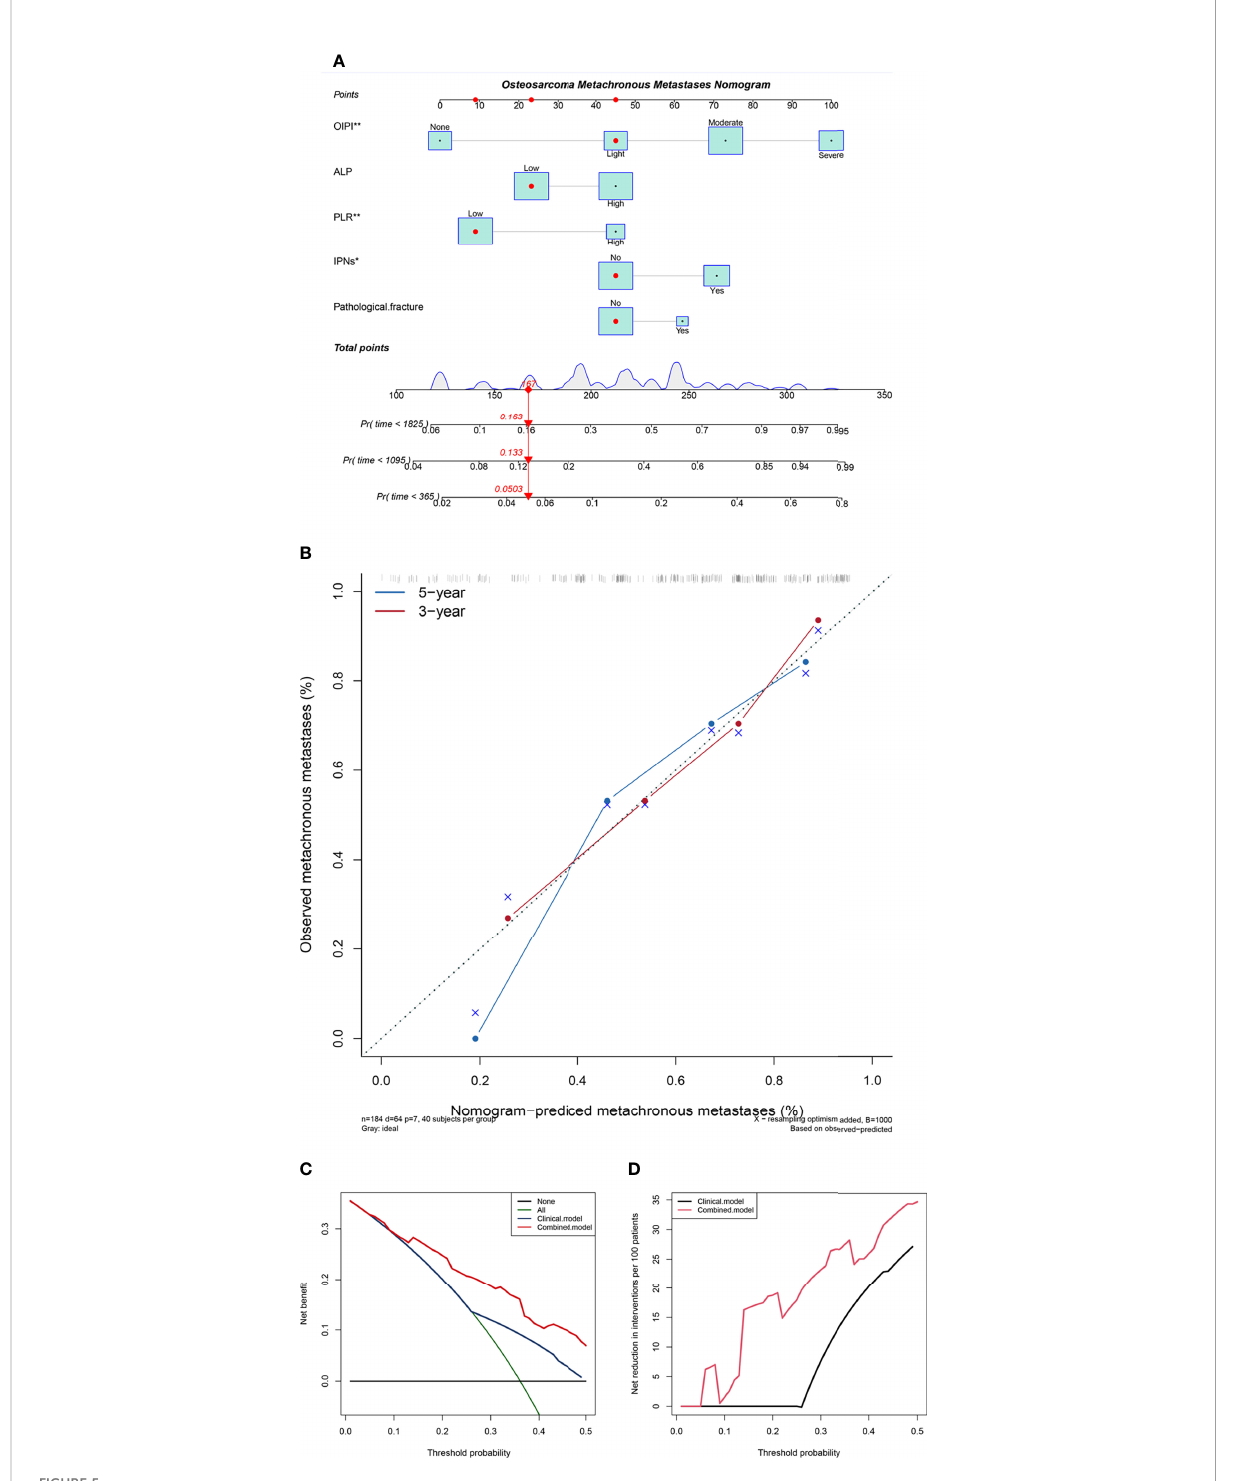
FIGURE 5 Construction and validation of the osteosarcoma metachronous metastasis nomogram. (A) The nomogram was constructed by combining OIPI, ALP, PLR, IPNs, and pathological fracture, and the sum of the scores for each covariate was the nomogram total score. (B) Calibration curves for the nomogram predicting 3- and 5-year metachronous metastasis of osteosarcoma patients. (C) The clinical net bene fi t curve of this nomogram. (D) Clinical net reduction curve for the nomogram. OIPI, osteosarcoma immune prognostic index; ALP, alkaline phosphatase; PLR, platelet – lymphocyte ratio; IPNs, indeterminate pulmonary nodules; *P < 0.05, **P < 0.01, ***P <